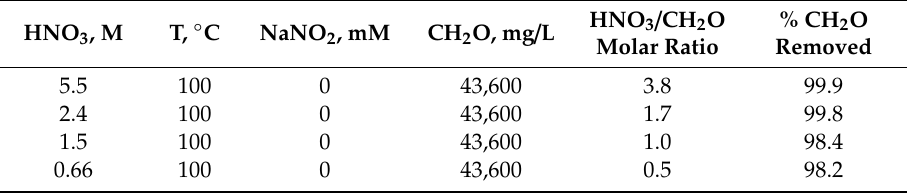
Table 5. Formaldehyde removal achieved by varying nitric acid concentration, working with highly concentrated synthetic